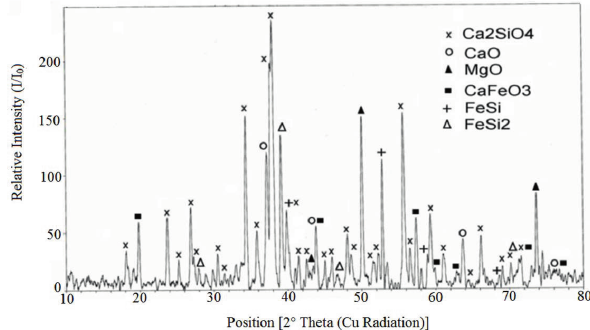
Figure 10. X-Ray diffraction of reduction residue (1523 K, 240